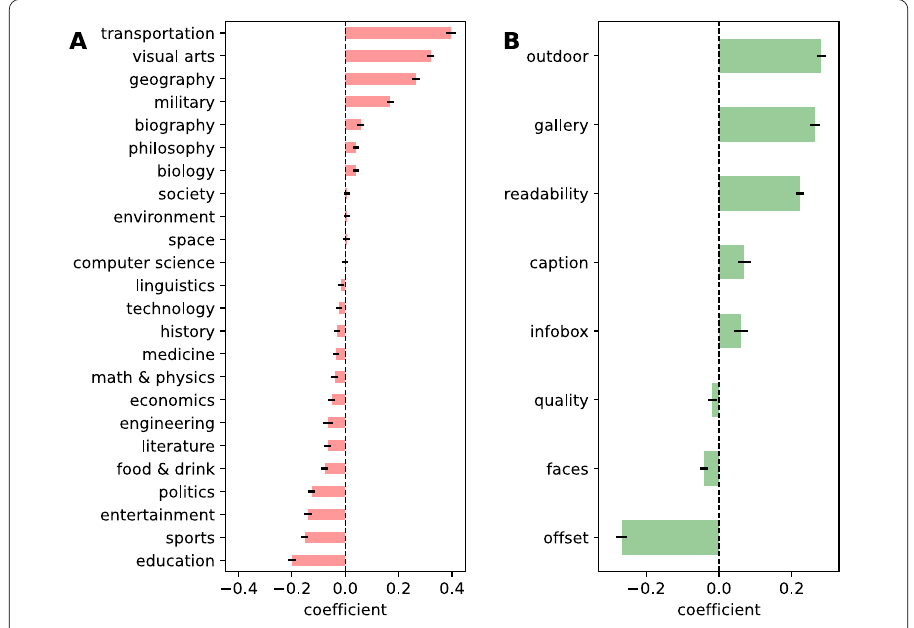
Figure 9 Association of the features with the image iCTR expressed as coefficients of the logistic regressions. ( A ) Coefficients of the model trained with topics of the article as predictors. ( B ) Coefficients of the model trained with the other variables of the image. Error bars represent 95% confidence